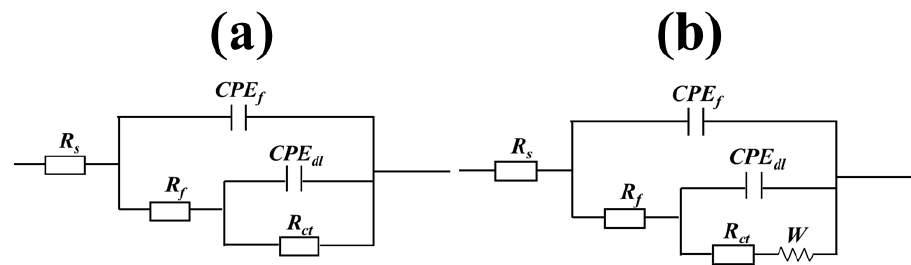
Figure 6. The equivalent circuit diagrams required to fit the impedance spectrum data: ( a ) fit the equivalent circuit diagram containing the itraconazole molecule, and ( b ) fit the equivalent circuit diagram in the blank solution.